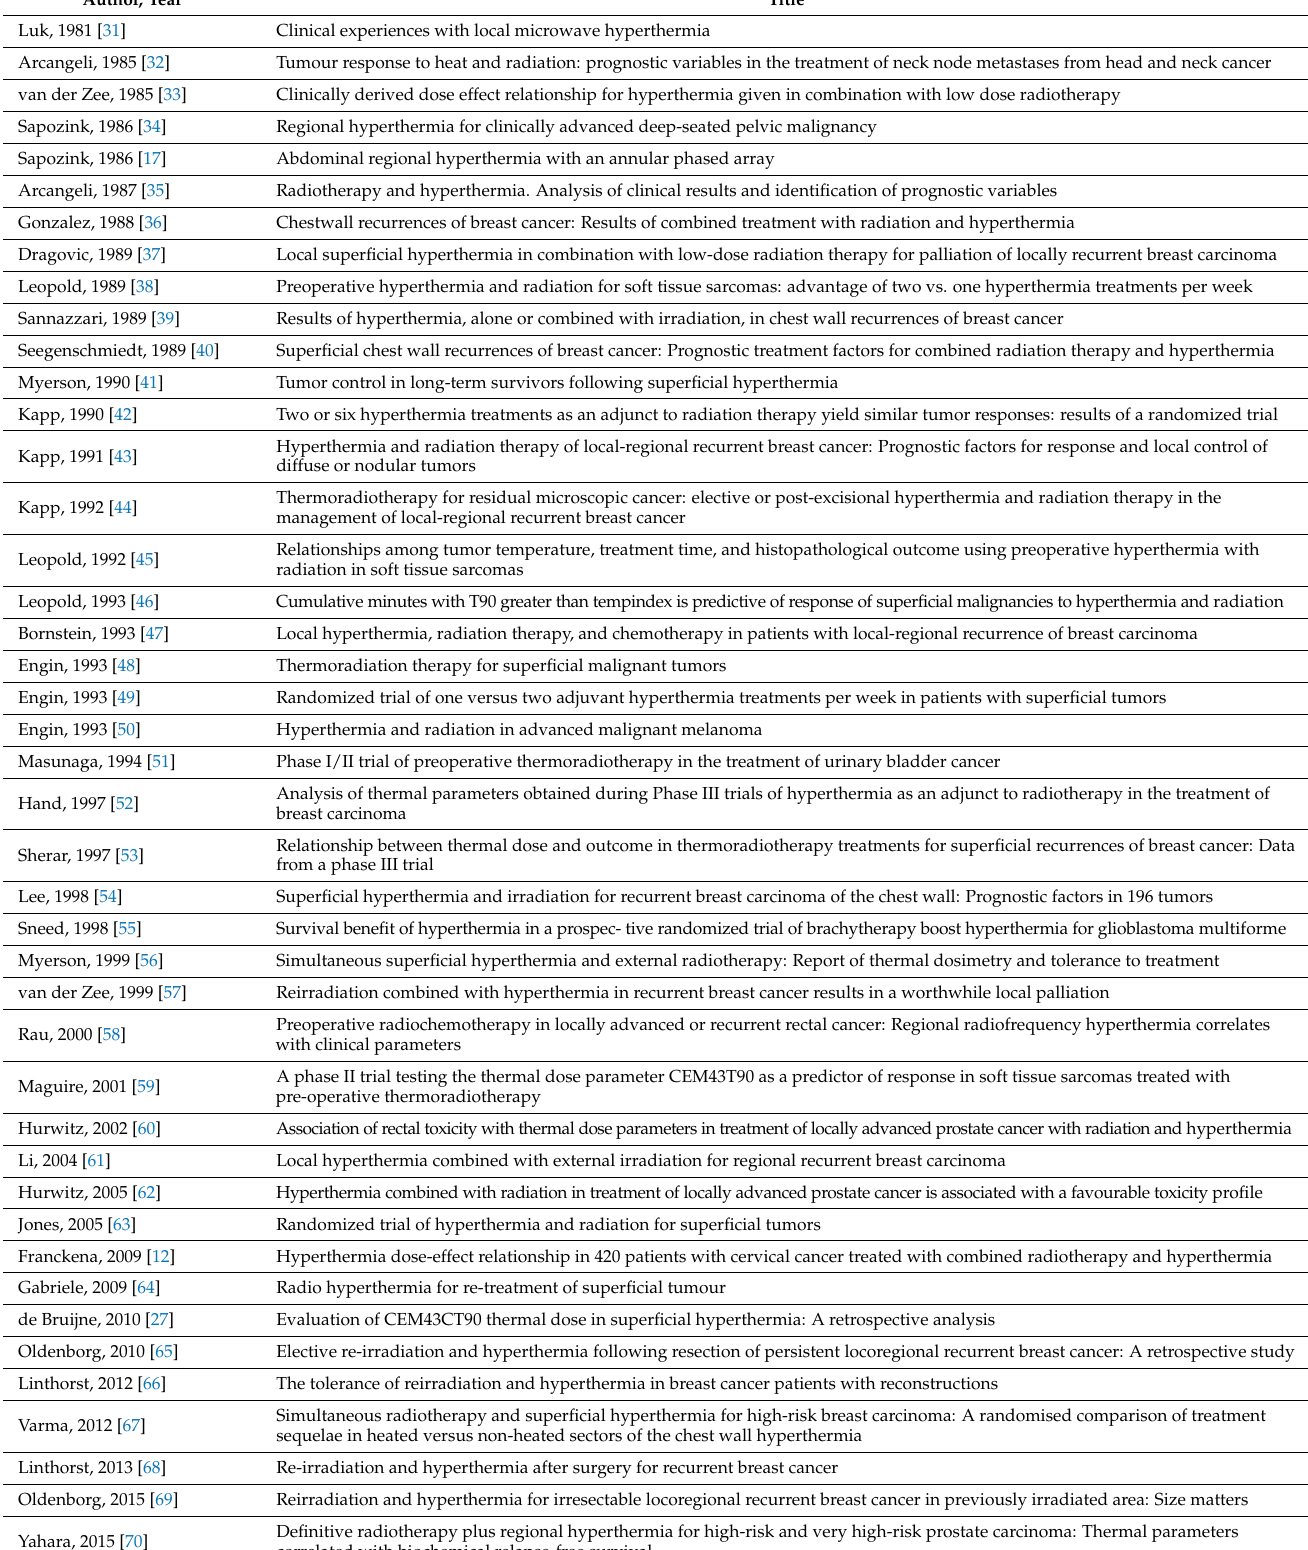
Table 1. Author, year, and title of the articles included in the systematic